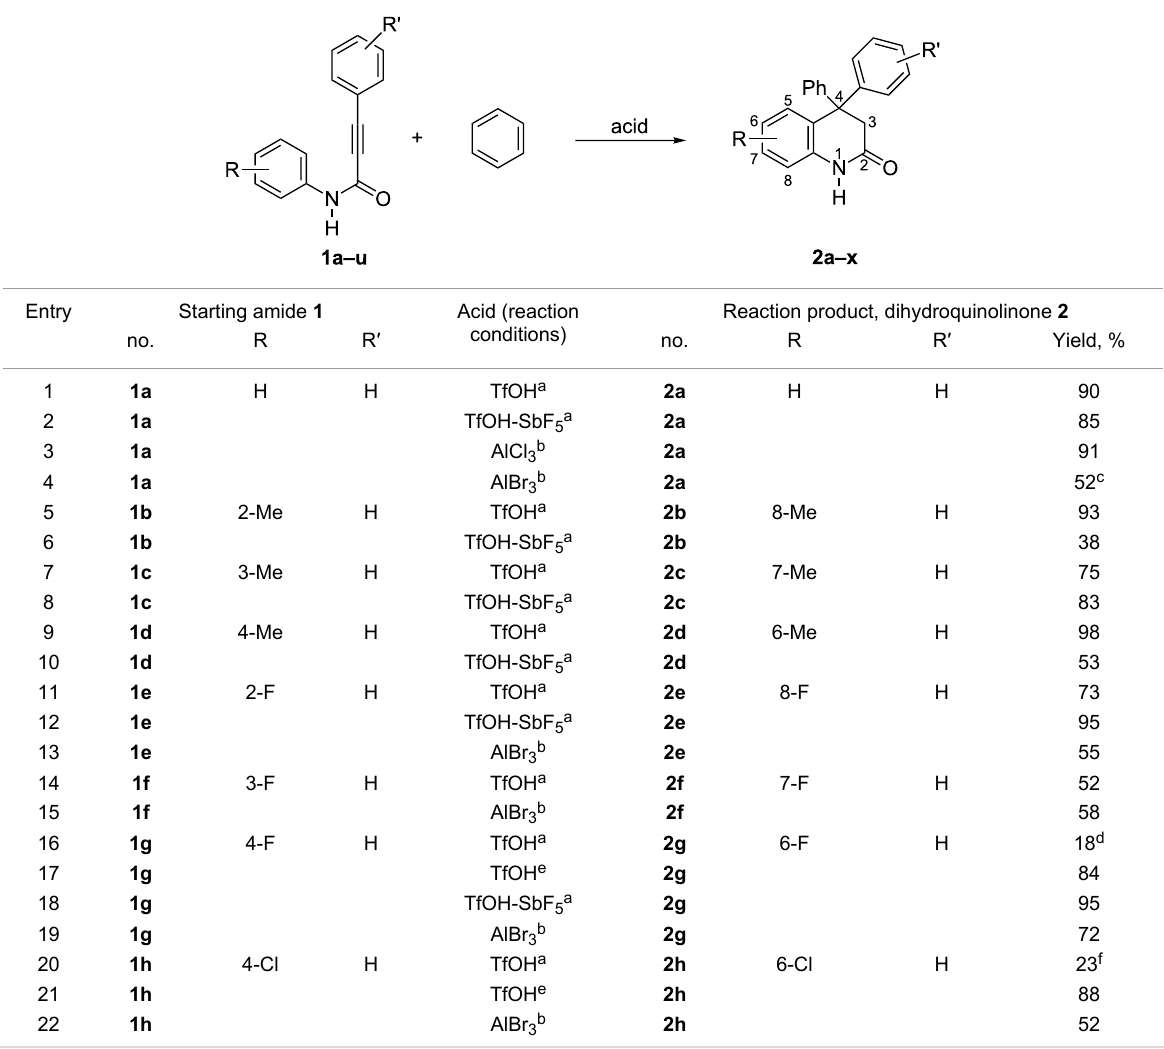
Entry Starting amide 1 Acid (reaction